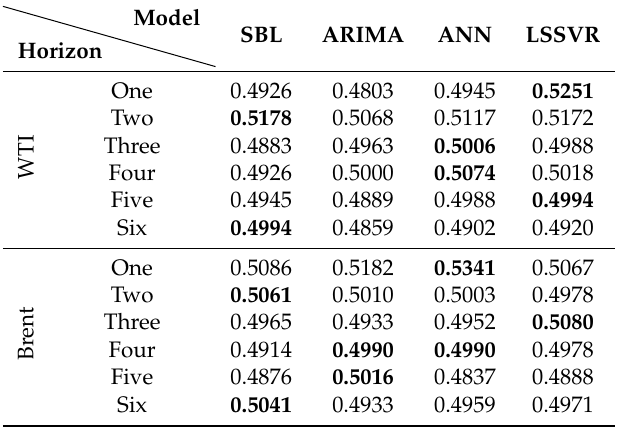
Table 3. The Dstat values by different single models on WTI and Brent crude oil